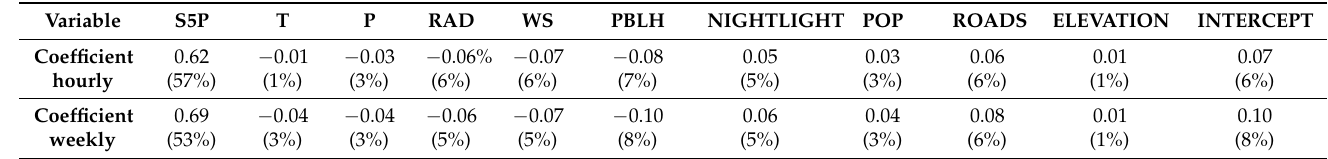
Table 3. Variables’ coefficients used for multilinear